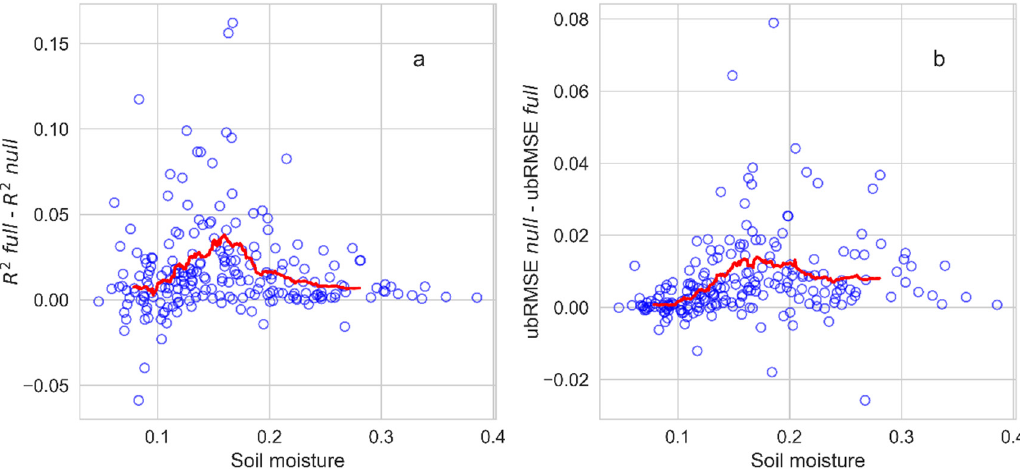
Figure 8. The difference in R 2 s between “ full ” model and “ null ” model reconstructed LAI predictions as a function of soil moisture ( a ), and the reduction in ubRMSE from the “ null ” model to “ full ” model as a function of soil moisture ( b ). The red lines in ( a , b ) are the moving average using a window length of 15% of the data.